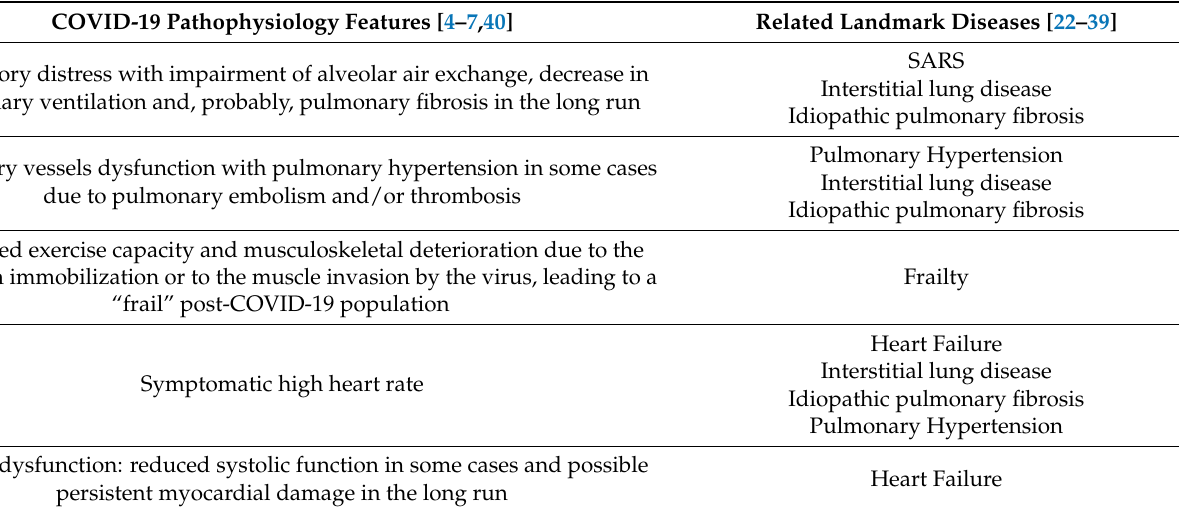
Table 2. Different pathophysiology features of COVID-19 and related pertinent